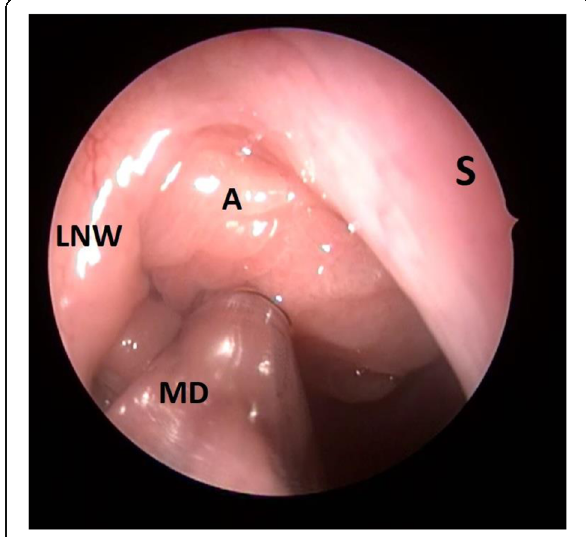
Fig. 3 Intraoperative transnasal endoscopy demonstrating shaving of the adenoid ( a ) using the micro-debrider (MD) [LNW, lateral nasal wall; S, nasal septum]